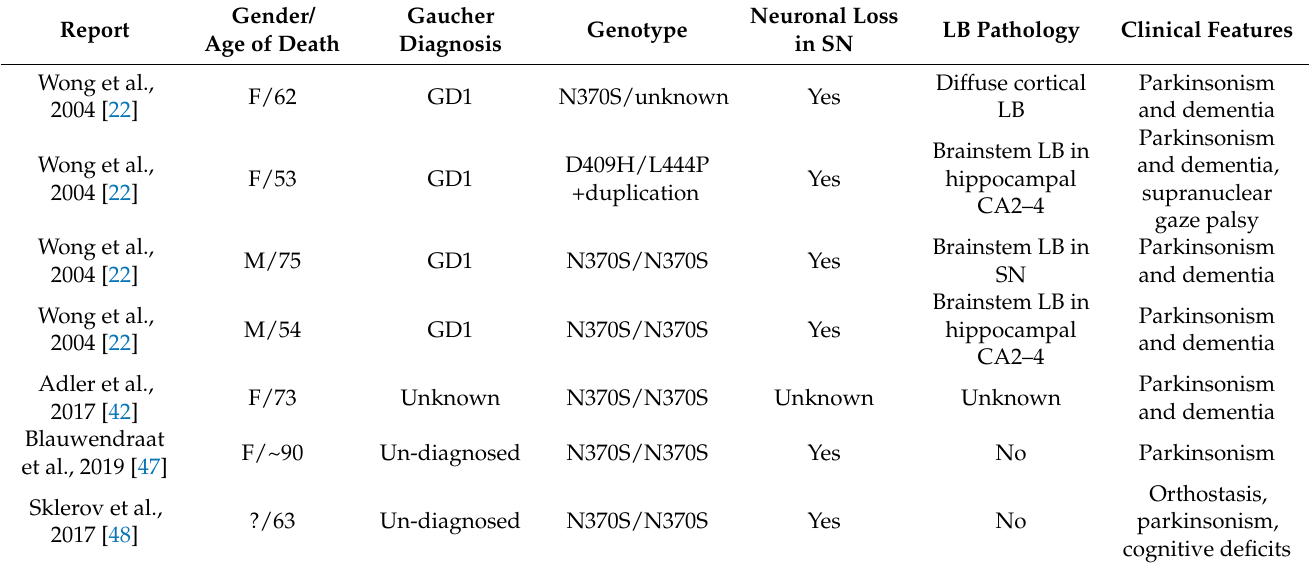
Table 1. Autopsy studies of patients with both Gaucher disease (GD) and